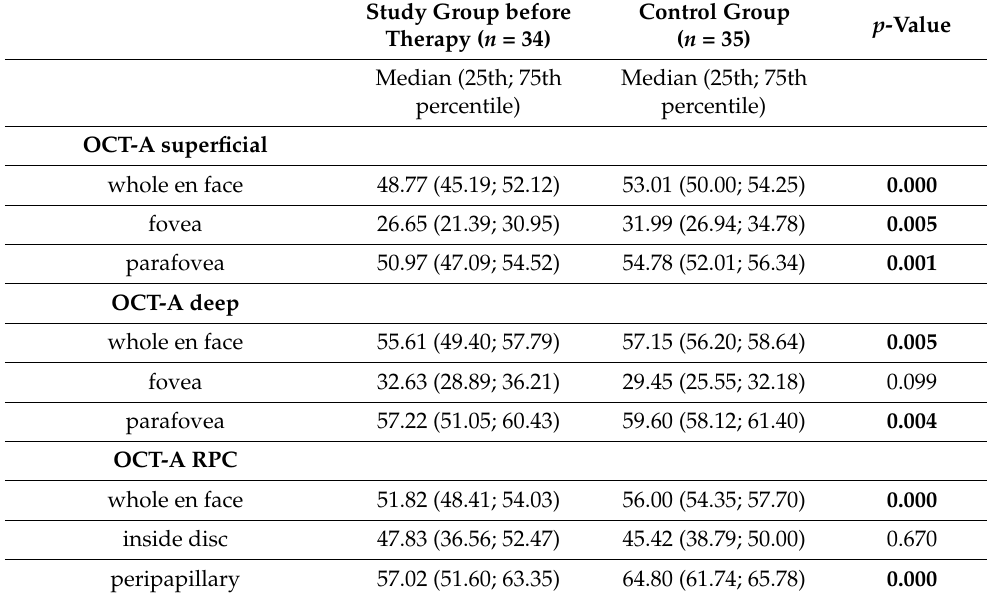
Table 2. Values of flow density (%) obtained in the regions indicated. Bold: statistically significant differences between AF patients and the control